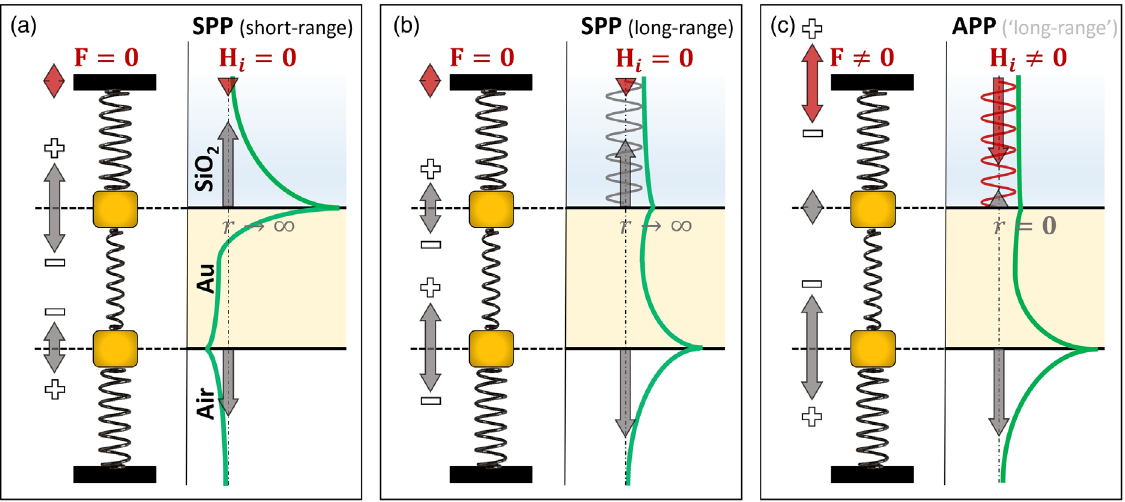
FIG. 2. Three plasmonic degrees of freedom in a thin film. Illustrated magnetic field profiles (green) of the two modal SPPs and the nonmodal APP of a thin metal film (yellow) illuminated via a dielectric substrate (light blue), and their mechanical analogue in a driven system of two coupled oscillators. (a) Short-range SPP localized on the metal-substrate interface and its anti-phase resonance analogue. (b) Long-range SPP and (c) the additional APP degree of freedom localized on the metal-air interface and their respective in-phase resonance and antiresonance analogues. Red arrows indicate the incident field amplitude H i and driving force F . Gray arrows indicate the scattered (reflected and transmitted) field amplitudes, and mechanical oscillation amplitudes with relative phases noted by plus- minus signs. The long-range SPP comprises only a reflected field in the substrate ( r → ∞ , H i ¼ 0 ), whereas the APP only an incident field ( r ¼ 0 , H i ≠ 0 ). Therefore, the APP carries power into the film [red since in (c)] while the long-range SPP leaks it away [gray since in (b)], as seen in Movie 2. Illuminating from the air side leads to a different APP that is localized on the metal-substrate interface (Appendix B